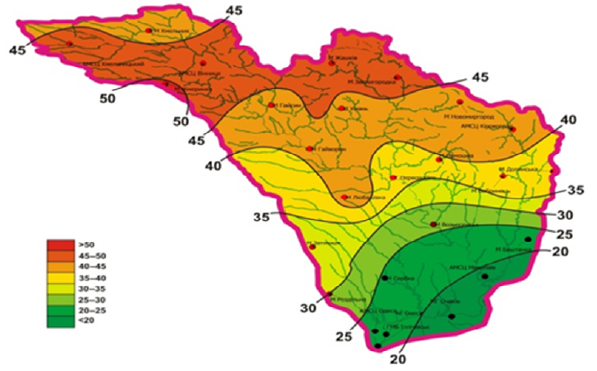
Figure 3. Distribution of average long-term maximal stocks of snow in the basin of the Southern Bug River, mm.